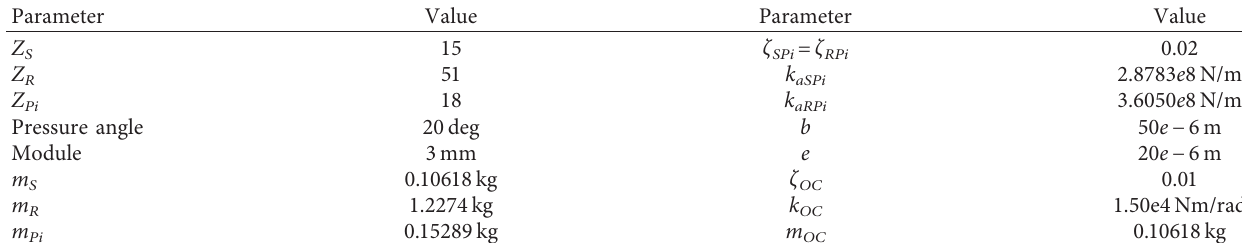
Table 1: Parameters of the